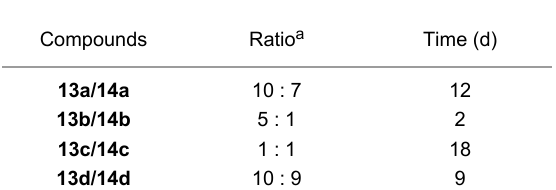
14a , c , d , respectively, equilibrated slowly in chloroform solu- tions to give stable ratios after several days at rt. These results are summarized in Table 1.